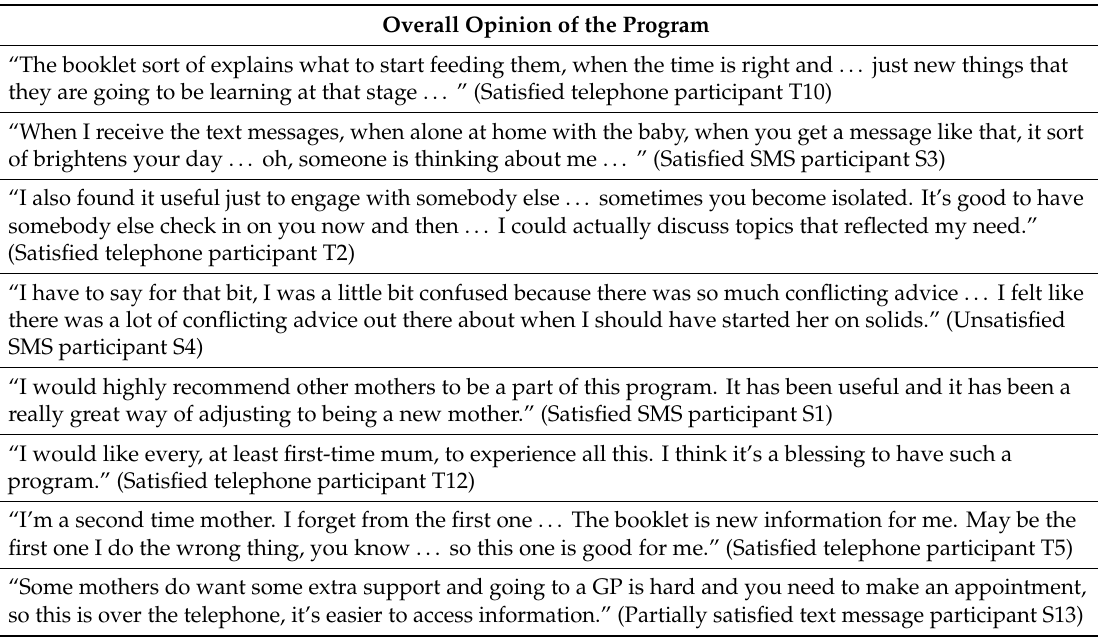
Table 5. Quotes supporting participants’ overall opinion of the